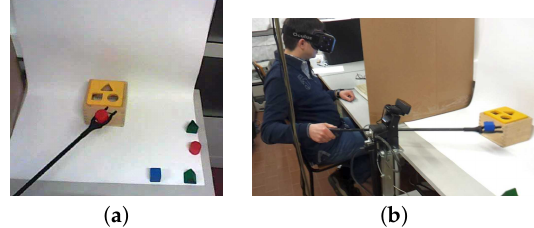
Figure 4. Task 2 setup used to compare performances: The user grabs blocks with a hand gripper and places them into a wood box through the corresponding hole, using ( a ) the traditional interface ( Fix Display + Fix Cam ) vs. ( b ) the immersive interface ( Rift Display + Mov Cam ).